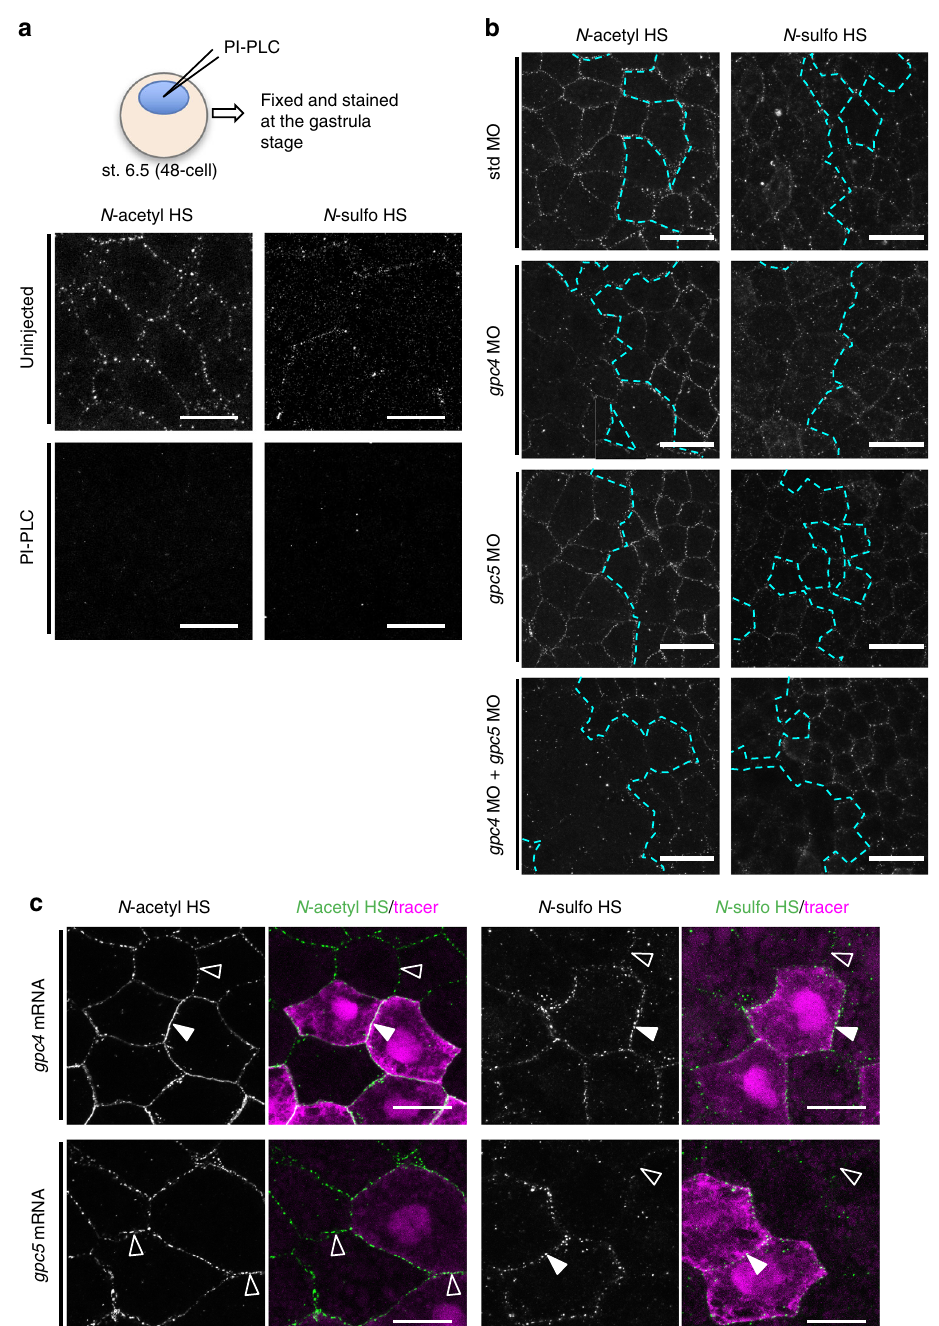
Fig. 4 Glypicans are core proteins for N- acetyl/ N- sulfo-rich HS clusters. a The reduction in the numbers of both N- sulfo-rich and N- acetyl-rich HS clusters by PI-PLC treatment. Embryos were fi xed and stained at st. 11.5 after blastocoel-injection of PI-PLC (800 μ U) at st. 6.5. b Effects of the knockdown of gpc4 , gpc5 or both on the formation of HS clusters. MOs with FITC-dextran were injected into a dorsal blastomere of 4-cell stage embryos. Boundaries of the tracer-positive regions (left side) are indicated by dotted cyan lines (see Supplementary Fig. 7a for tracer images). The reduction of N- acetyl-rich HS clusters was observed with gpc4 MO alone, whereas that of N- sulfo-rich HS clusters was apparent only with the combination of gpc4 MO and gpc5 MO. Amounts of MOs (ng/embryo), std MO, 28; gpc4 MO and gpc5 MO, 14. c Effects of the overexpression of gpc4 or gpc5 on the formation of HS clusters. mRNA for gpc4 or gpc5 was coinjected with mRFP mRNA into the animal pole region of a ventral blastomere at the 4- or 8-cell stage and fi xed at the gastrula stage (st. 11.5) and stained. Upper panels, exogenous gpc4 expression increased the number of both N- sulfo-rich and N- acetyl-rich HS clusters (white arrowheads), compared with the cell boundaries of tracer-negative cells (open arrowheads). Lower panels, gpc5 expression did not increase the number of N- acetyl-rich HS clusters (open arrowheads) but did increase the number of N- sulfo-rich HS clusters (white arrowhead). Amounts of injected mRNAs (pg/embryo): gpc4 and gpc5 , 50; mRFP , 400. See also Supplementary Fig. 7b for gpc Δ HS mutants. Images are a representative of at least two independent experiments. Scale bars, 20 μ m ( a , c ); 40 μ m ( b